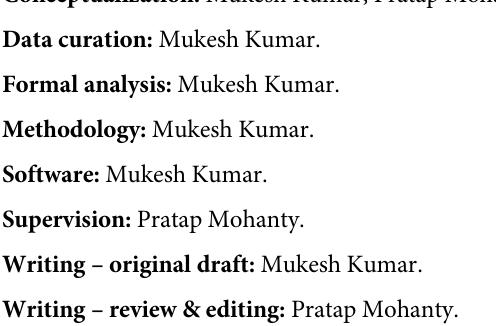
S1 Table. Predicted probabilities of double burden of malnutrition among mother-child dyads by familial, maternal, and child covariates in India. S2 Table. A sub-sample multivariable analysis with 60 percent of the total sample of dou- ble burdened mother-child pairs. S3 Table. Distribution of any form dual burden of malnutrition (overweight or obese mother and underweight/stunted/wasted child) by familial, maternal and child covariates. S4 Table. Logistic regression results of any form of dual burden of malnutrition (over- weight or obese mother and underweight/stunted/wasted child) by familial, maternal and child